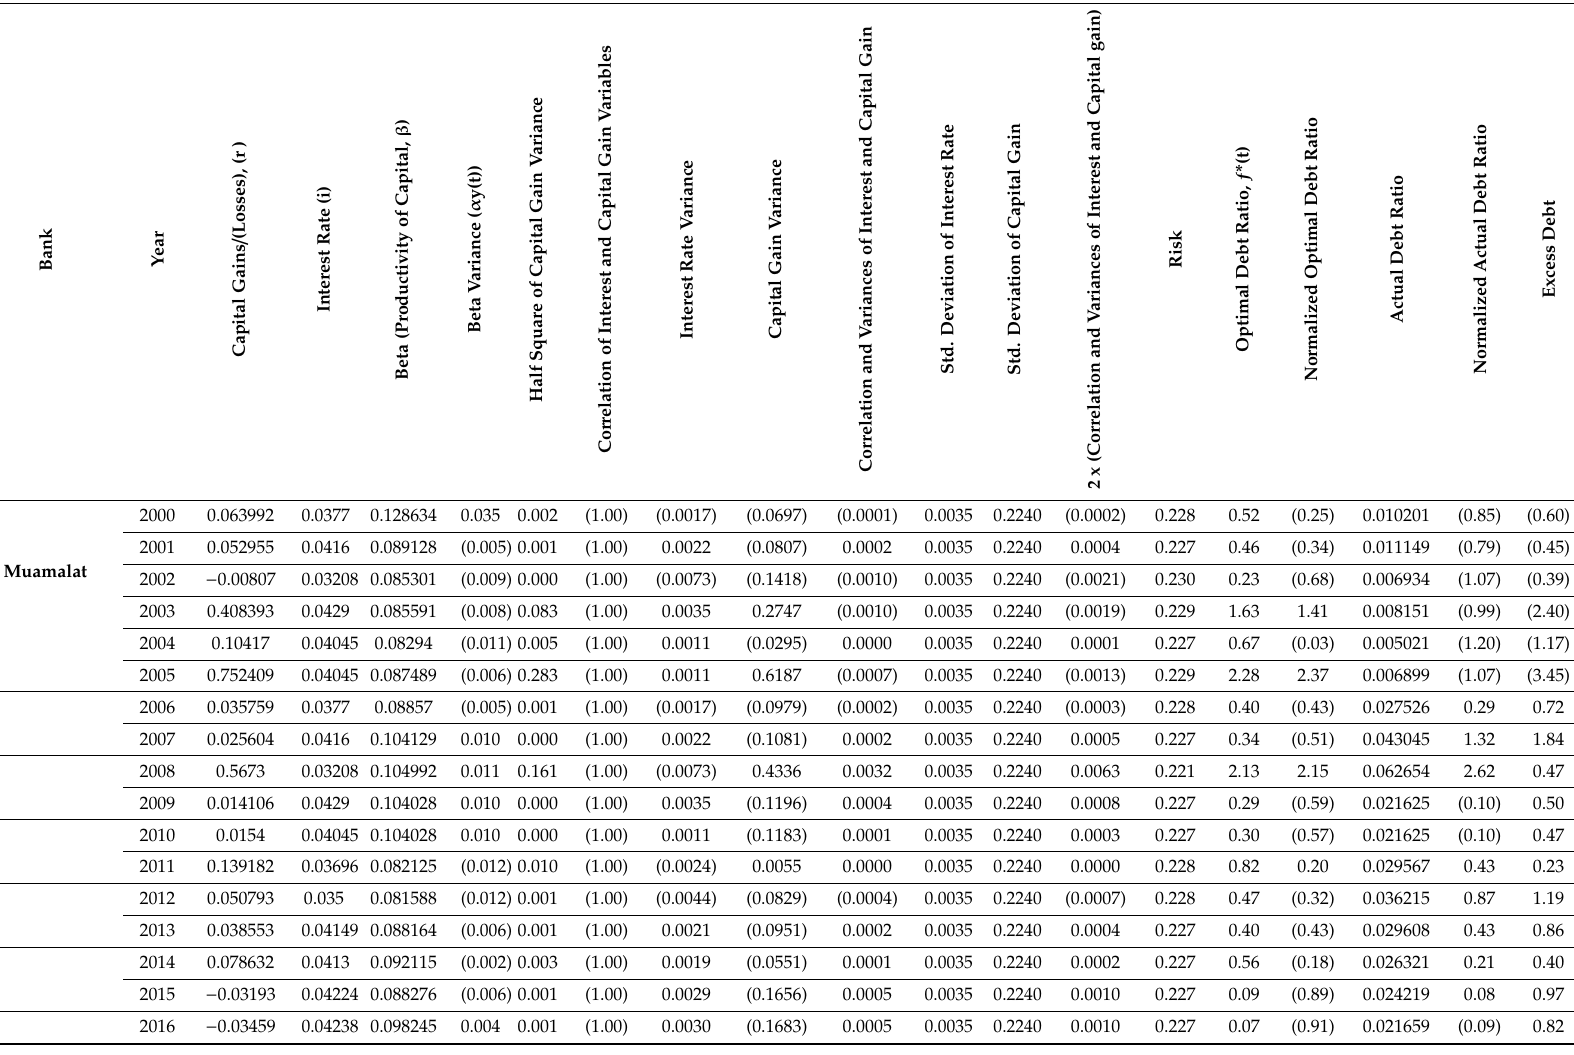
Table A13. Calculations of Optimal and Excess Debt: